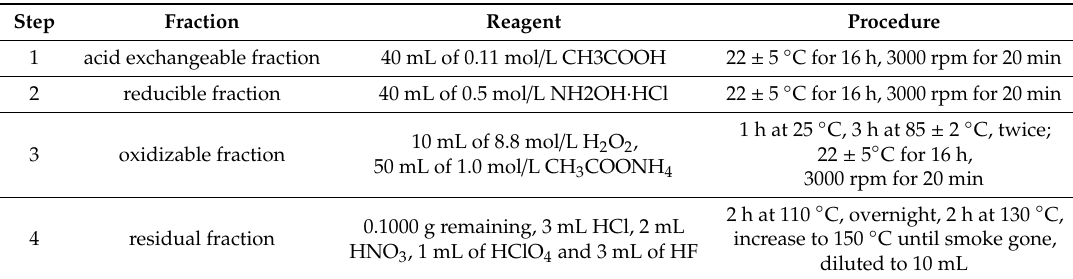
Table 3. The modified BCR sequential extraction